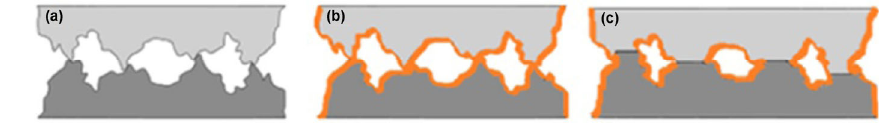
Fig. 12 The contact complications in mixed and boundary lubrication